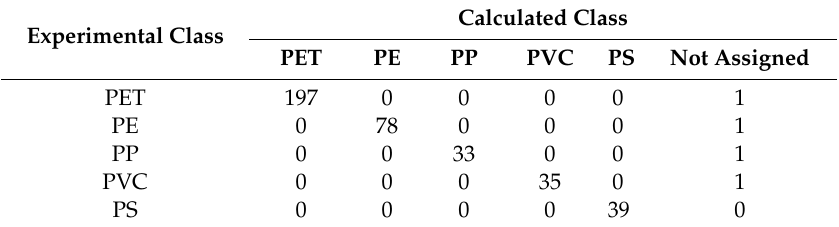
Table 3. Confusion matrix obtained from the PLS-DA model fitted on the validation set. The “Not Assigned” column contains samples which were not assigned to any of the considered classes.